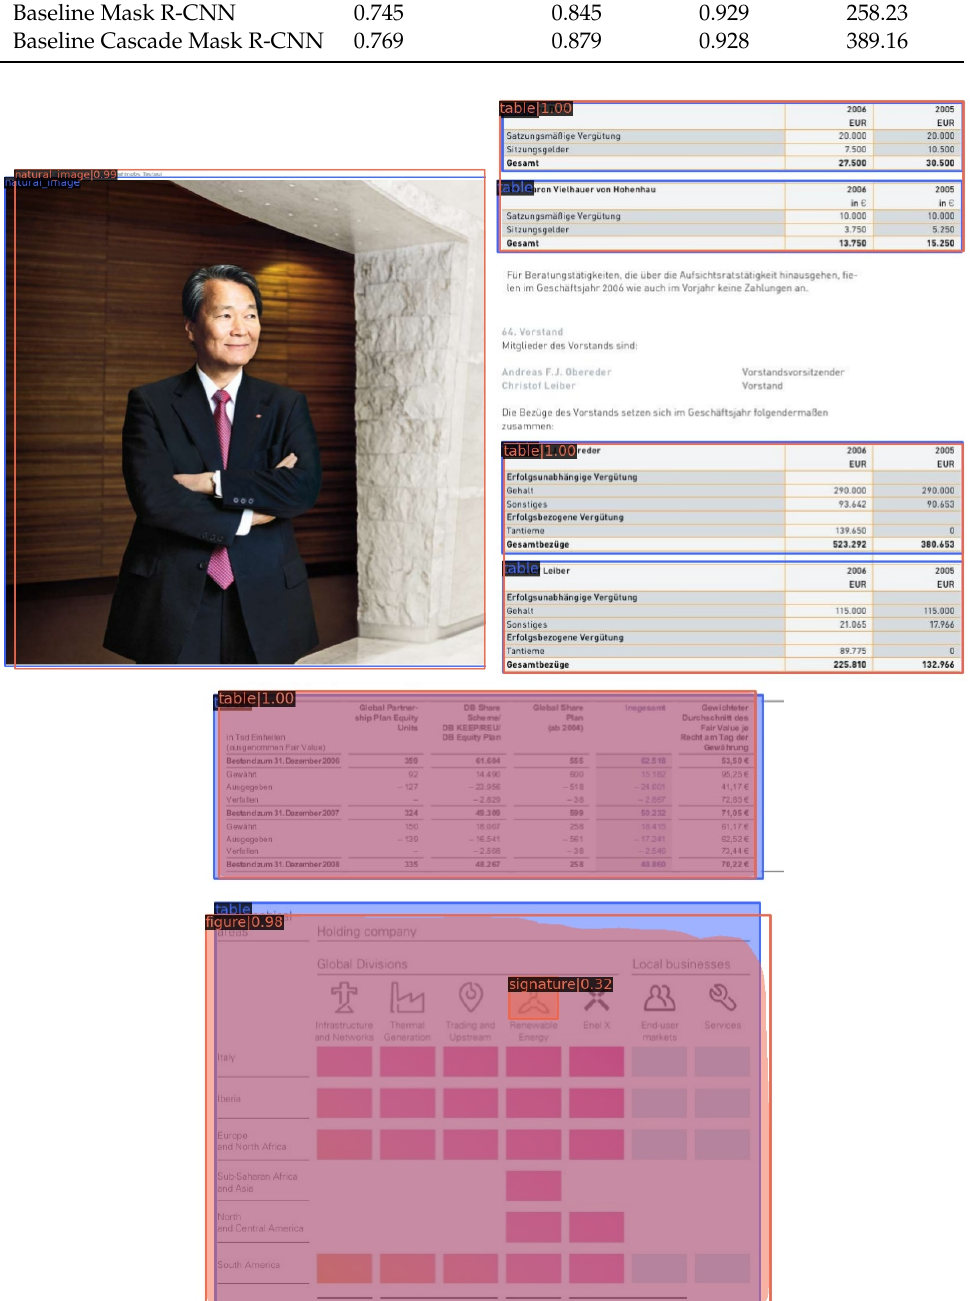
Figure 8. Visualizing some detection results for the models in Table 6. First row: The first and second images show true positive and false positive detection results for the baseline Faster R-CNN, respectively. Second row: The top and bottom images show the true positive and false positive detection results for the baseline Cascade Mask R-CNN